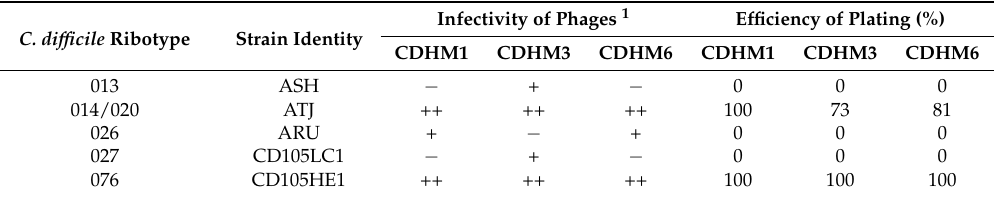
Table 1. Host range and efficiency of plating of C. difficile phages CDHM1, CDHM3 and